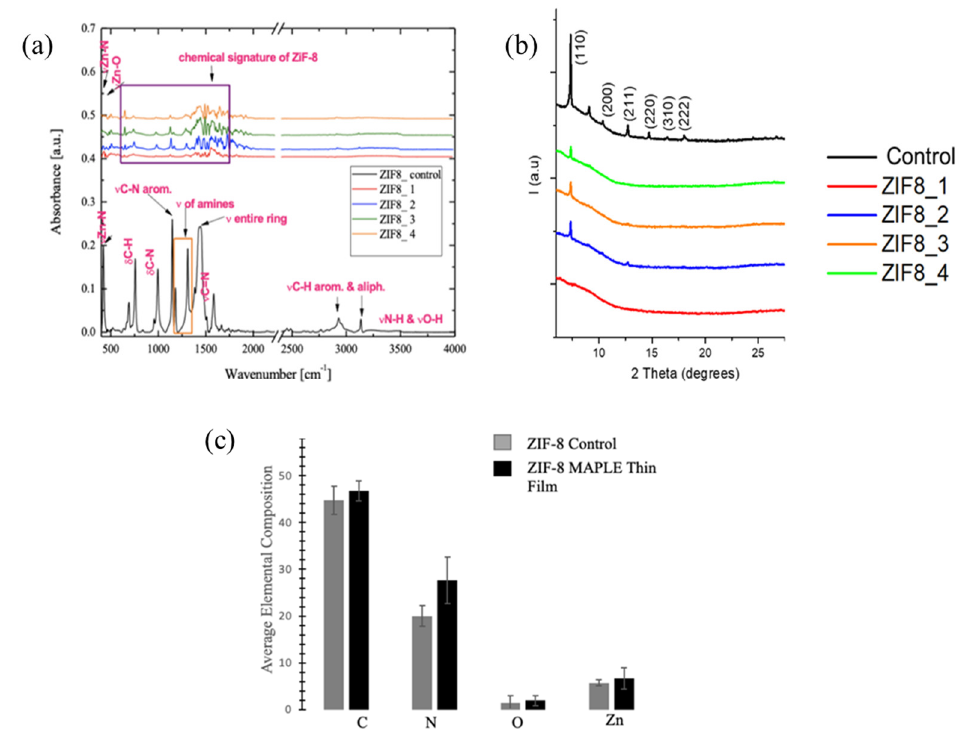
Figure 3. ( a ) FTIR spectra of ZIF-8 control and representative MAPLE deposited films (obtained at fluences of 0.3 J cm − 2 (ZIF8_1), 0.45 J cm − 2 (ZIF8_2), 0.6 J cm − 2 (ZIF8_3), and 0.8 J cm − 2 (ZIF8_4)). ( b ) XRD analysis of ZIF-8 control and MAPLE samples deposited at different laser fluencies; ( c ) Re- spective average elemental compositions of ZIF-8 control and representative MAPLE deposited